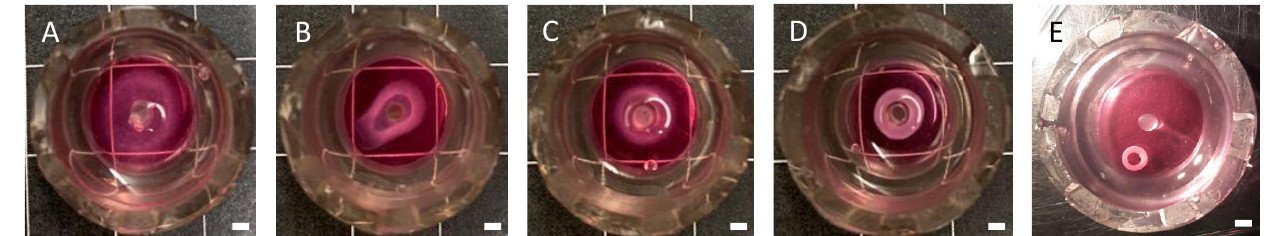
Figure 3. Images of EHM rings taken 24 h after casting the gel using different cell densities ( A – D ): 100; 200; 400 and 2000 CF cells/ μ L using a 1 mg/mL collagen concentration. The images show the top view of the EHM-rings within the clear silicone mold on a black background with white grid (1 cm by 1 cm). Surrounding the central pole is a light pink circle, most left vaguely showing, becoming clearer with increasing the cell density; The final image ( E ) shows the EHM-ring (8000 cells/µL, 1 mg/mL collagen concentration) after 7 days of culturing, next to the central pole. The EHM ring has been removed from the central pole manually to enhance visibility. Bars represent 2 mm.